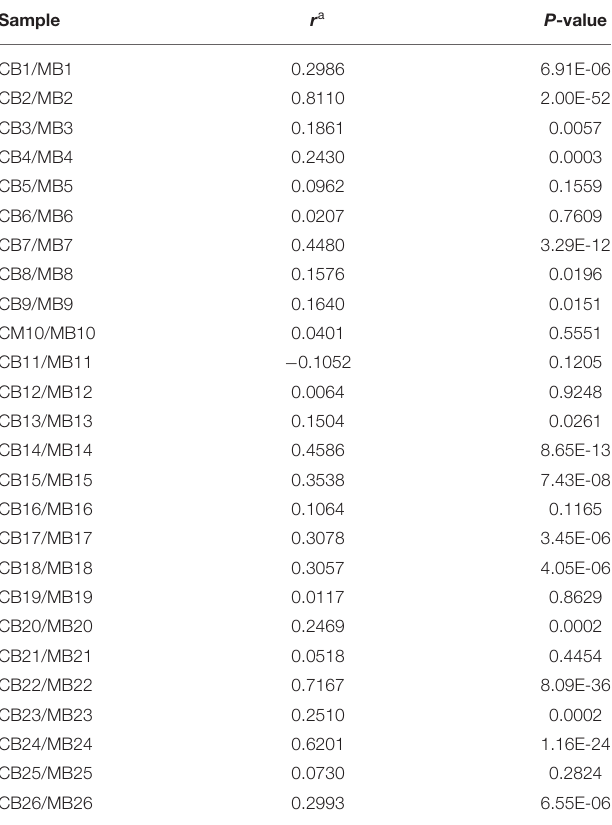
TABLE 1 | Correlation of IgG reactivities to glycans in matched cord blood and maternal blood samples. Sample r